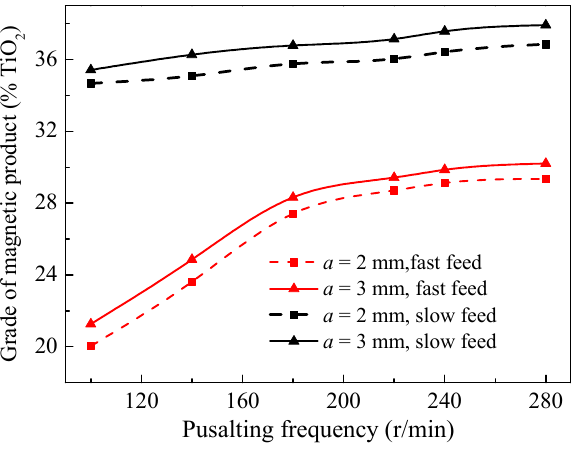
Figure 8. Effect of pulsating frequency on capture selectivity of single-wire with different feed modes.